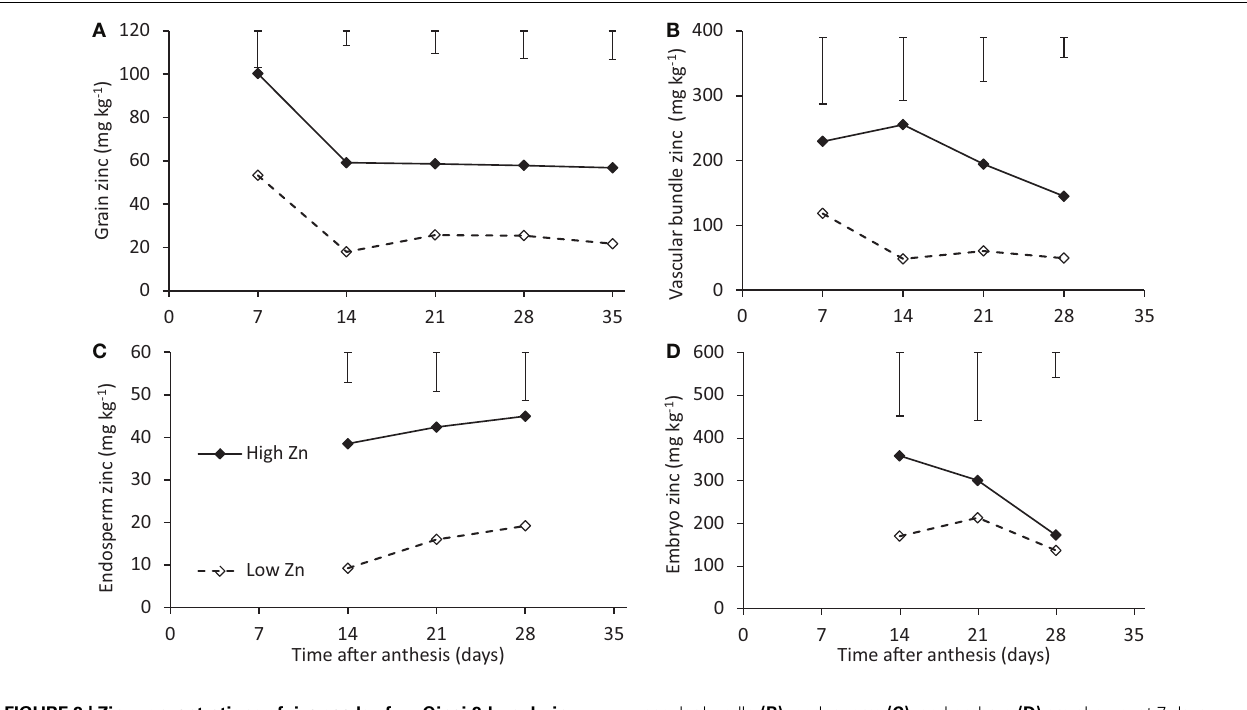
vascular bundle (B) , endosperm (C) , and embryo (D) are shown, at 7 days after anthesis no good distinction could be made between embryo and endosperm so tissues were lumped. Note that the scales along the y-axes